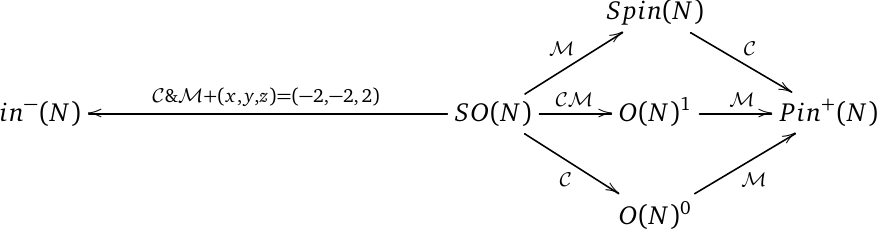
Table 2: Identifications between the zero-form global symmetries C , M , ( − 1 ) F of SO ( N ) . K